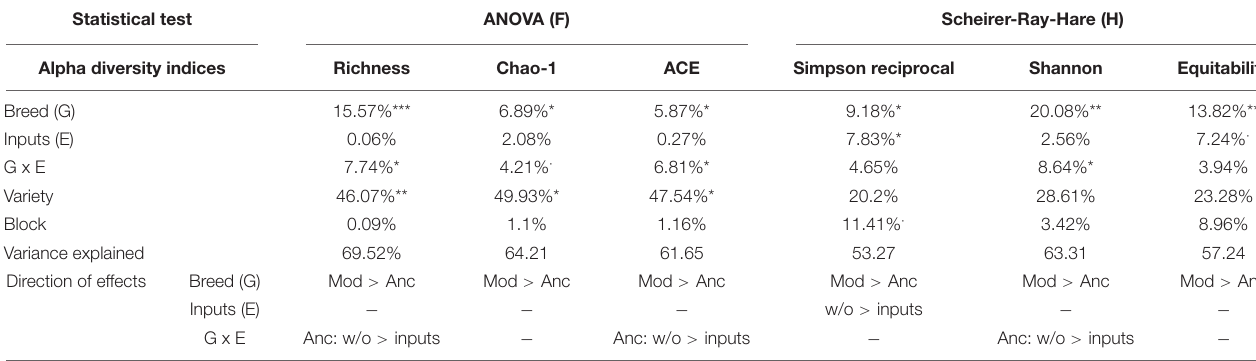
TABLE 3 | Analysis of variance for bacterial alpha diversity indices.